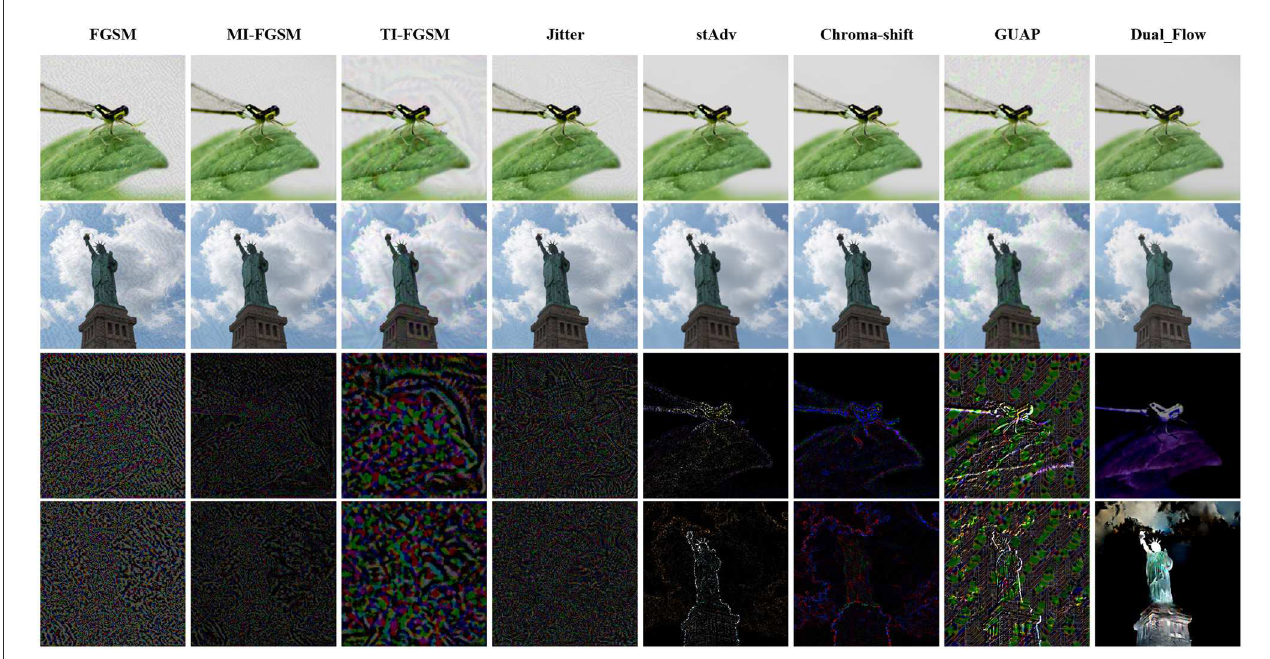
FIGURE3 Adversarial examples and their corresponding perturbations. The first two columns are the adversarial examples, and the followings are the adversarial noise of FGSM, MI-FGSM, TI-FGSM, Jitter, stAdv, Chroma-shift, GUAP and our method, respectively.